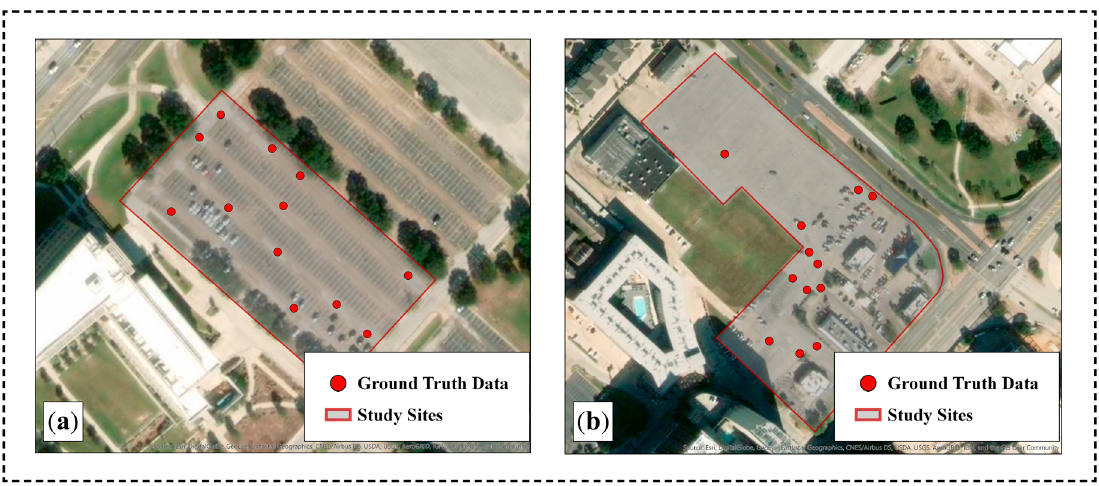
Figure 6. Study sites: (a) Parking lot 1; (b) Parking lot 2.